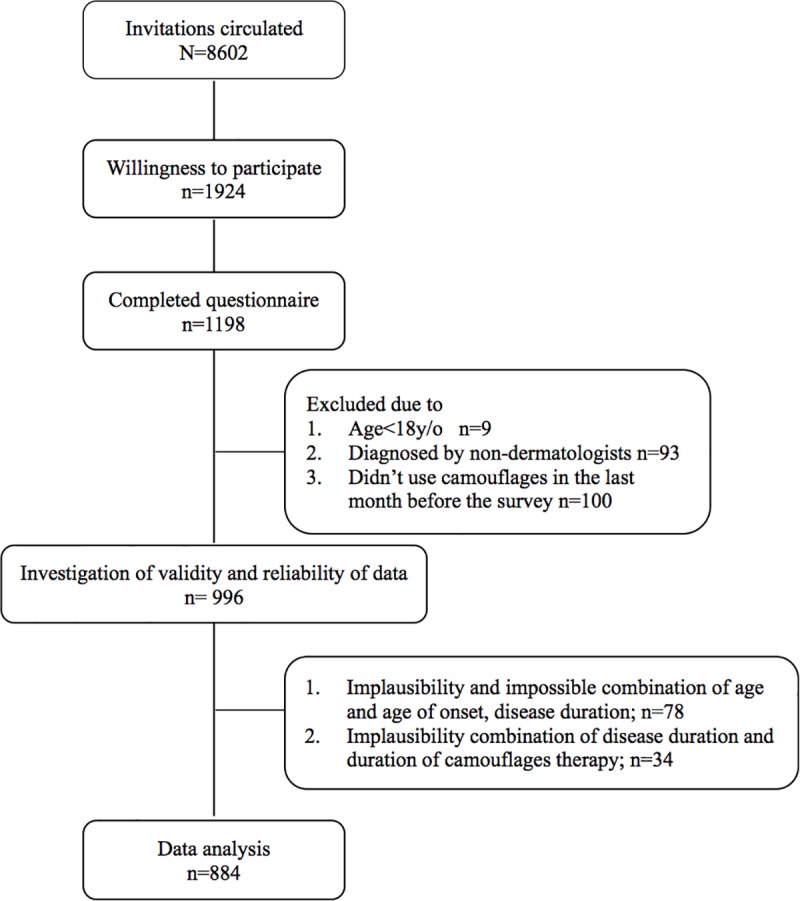
Flow diagram of patient enrollment, exclusion, data quality control and data analysis.(Online completion ensured that there were no missing data in completed questionnaires).